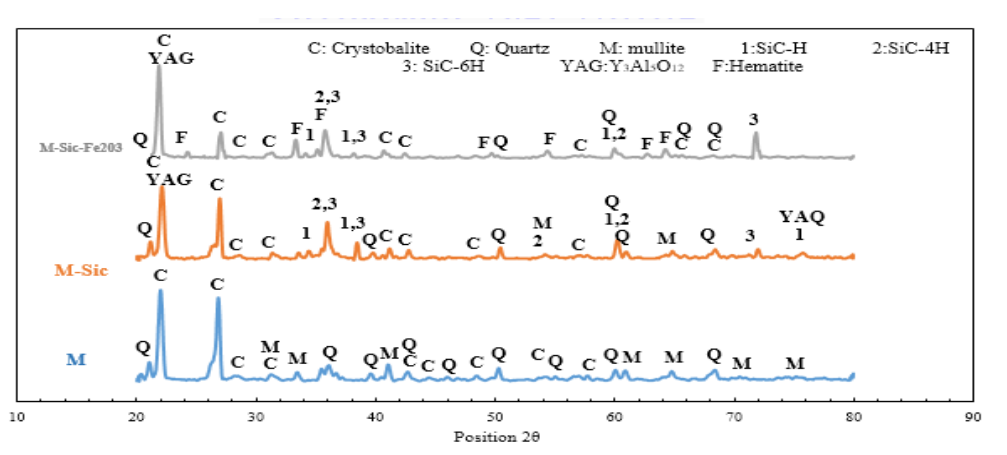
Figure 8. TGA of M, M/SiC30 and M/SiC/Fe20 microfiltration membranes. The first stage of weight loss of the M microfiltration membrane is probably related to the removal of moisture. The second stage of weight loss occurred between 400 and 650 ℃ , which was the result of the phase change and the formation of metakaolin from the kaolinite phase (according to reaction (1)) [45]. 2AL 2 Si 2 O 5 (OH) 4 → 2AL 2 SiO 7 + 4H 2 O